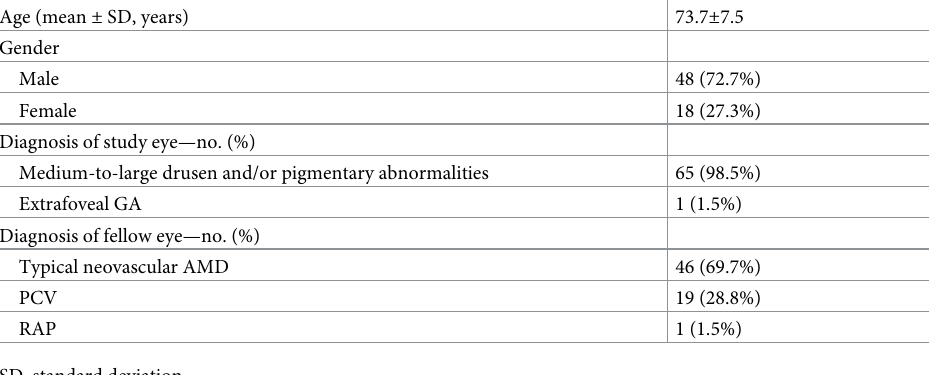
Table 1. Baseline profiles of 66 study patients.